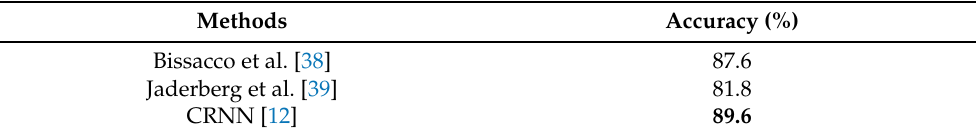
Table 7. Recognition results on ICDAR 2013.